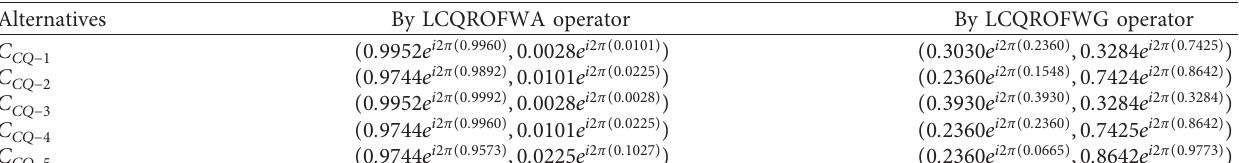
Table 4: Collective values by using LCQROFWA and LCQROFWG operators for Example 3.